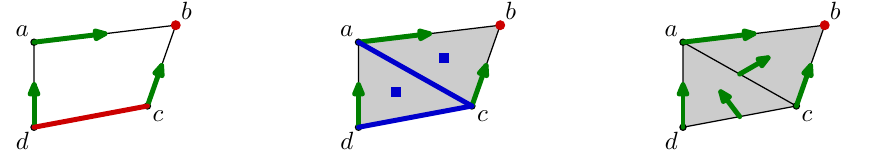
Figure 7. Discrete vector field update while inserting simplices.